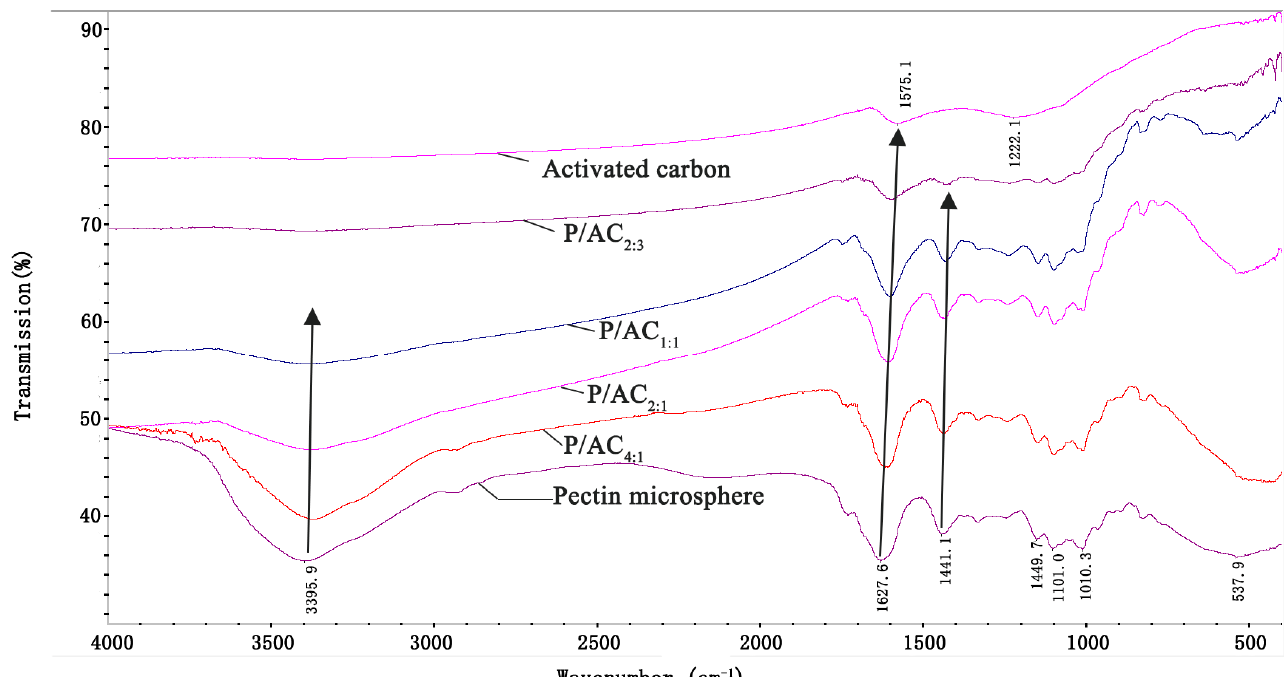
Figure 1. FTIR spectra of pectin microsphere, activated carbon, and P/ACs.